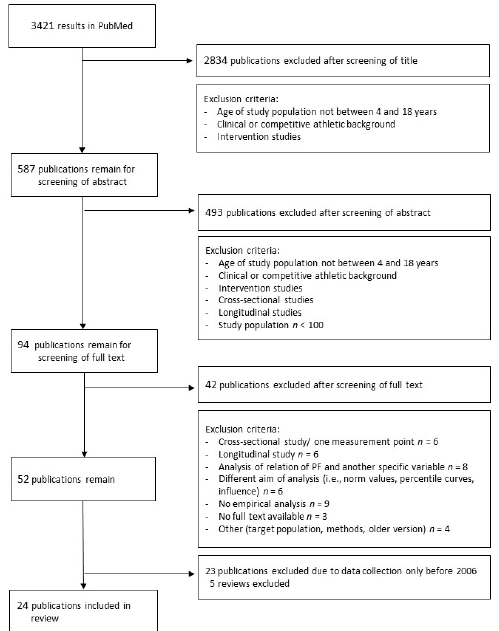
Figure 1. Flow chart of study selection process.